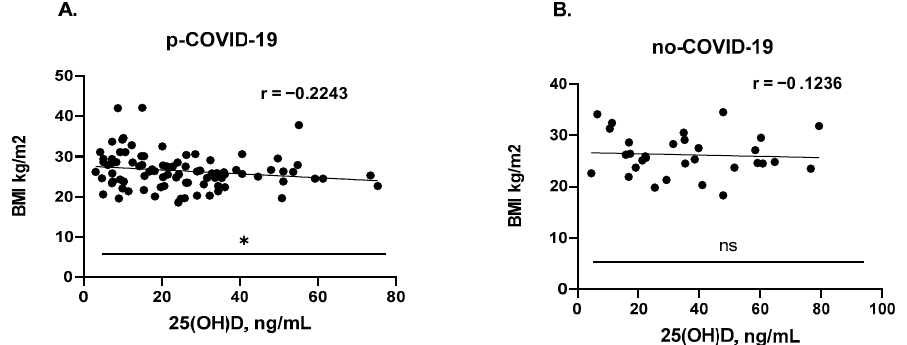
Figure 3. Relationship between plasma 25(OH)D levels and BMI among p-COVID-19 ( A ) and no COVID-19 ( B ) participants; * p = 0.357, ns = not significant; r = correlation coe ffi cient.